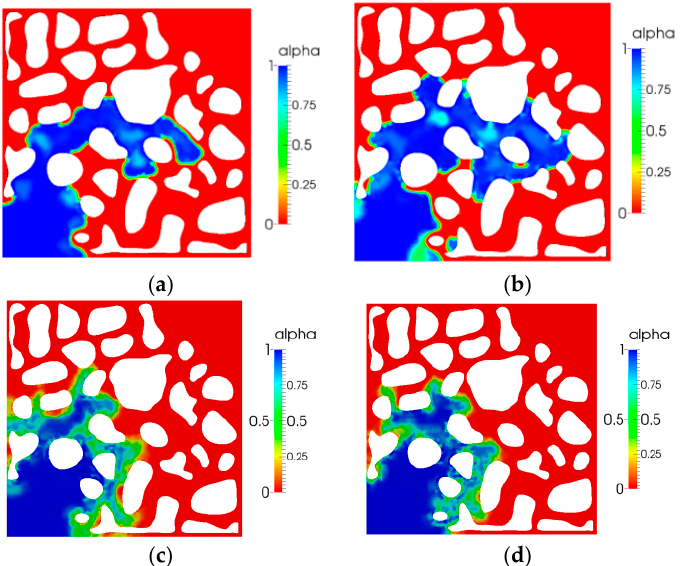
Figure 6. Volume fraction distribution ( t = 11 s): ( a ) water flooding; ( b ) polymer flooding (no elasticity); ( c ) polymer flooding ( λ = 0.01); and ( d ) polymer flooding ( λ =